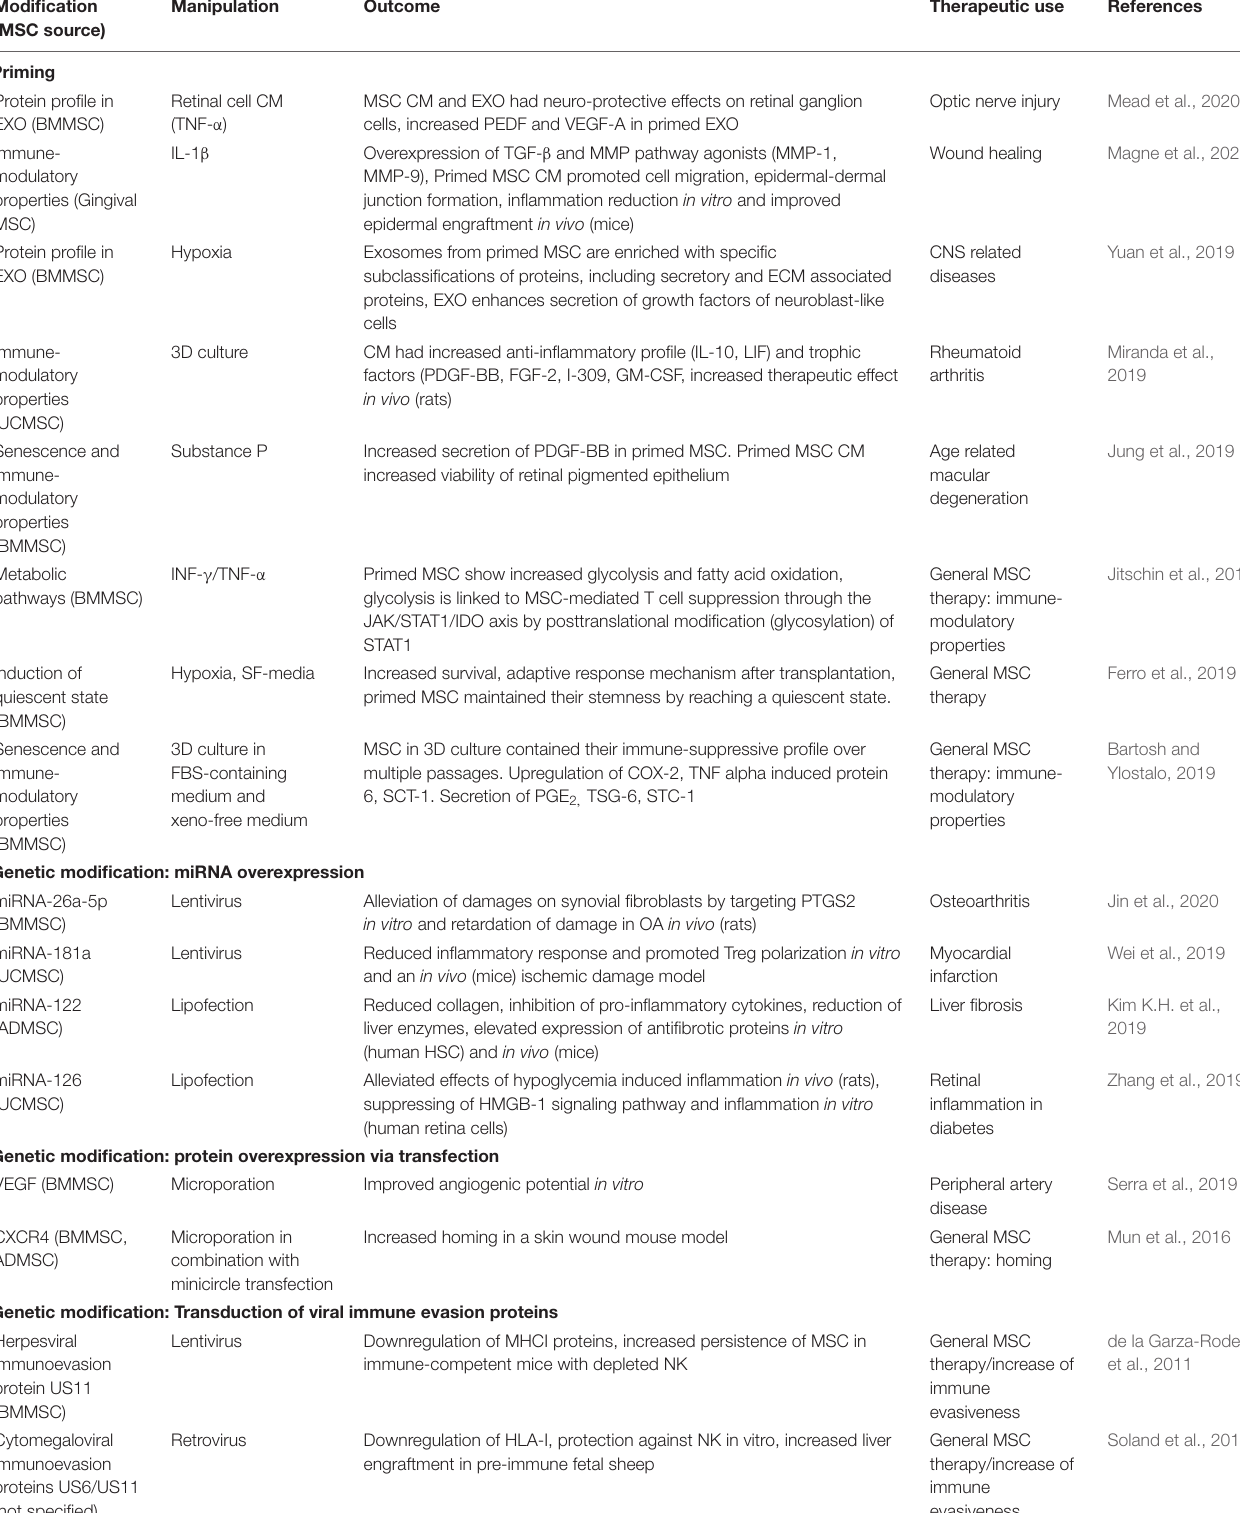
TABLE 3 | Manipulation of human MSCs to optimize the therapeutic effects of the MSC